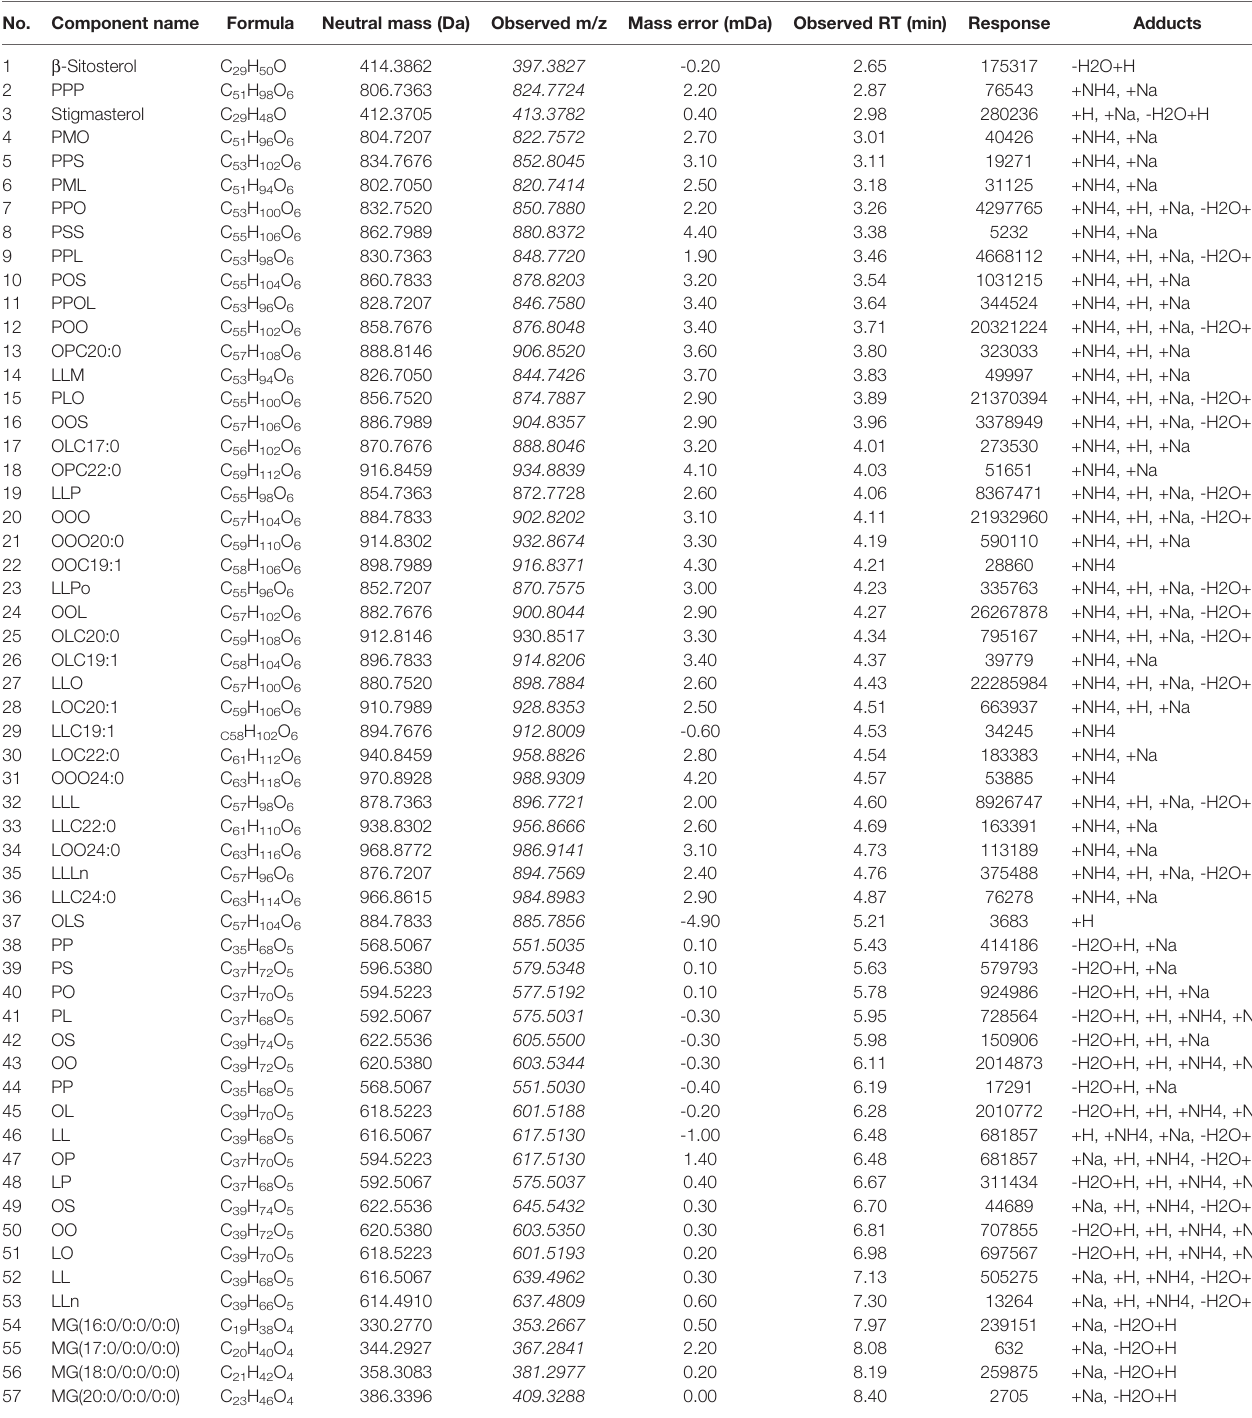
TABLE 1 | The qualitative results of glycerides in coicis semen oils in ESI +